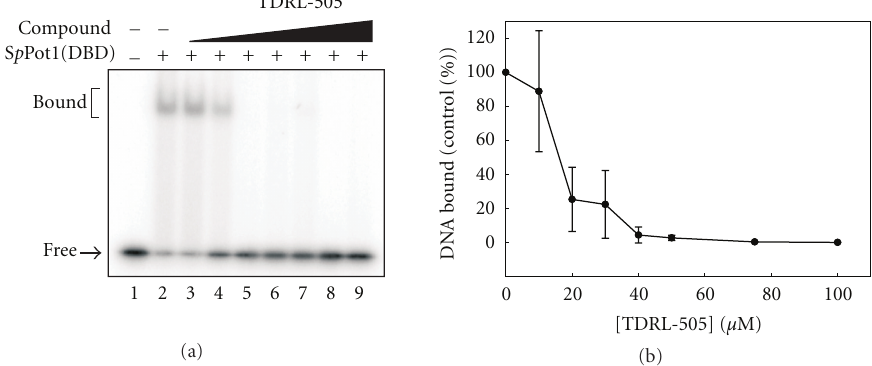
Figure 7: TDRL-505 inhibits Sp Pot1(DBD) ssDNA binding. (a) Titration of TDRL-505 in ssDNA-binding reactions with Sp Pot1(DBD). TDRL-505 was preincubated with Sp Pot1(DBD) (0, 25, 50, 100 μ M) prior to EMSA analysis of binding to the 15-mer oligonucleotide. “Free” ssDNA is indicated with an arrow, and the “Bound” ssDNA is indicated by a bracket. (b) Analysis of TDRL-505 inhibition of Sp Pot1(DBD). The average of three independent experiments is presented with SD.